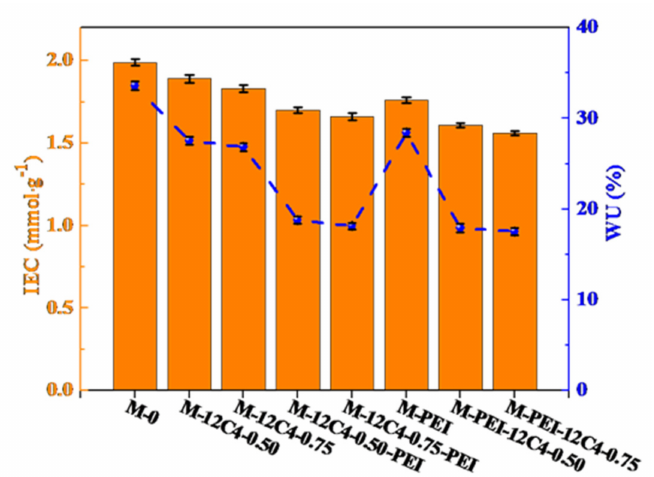
Figure 5. IECs and WUs for the pristine (M-0) and modified membranes (M-PEI, M-12C4-x, M-12C4-